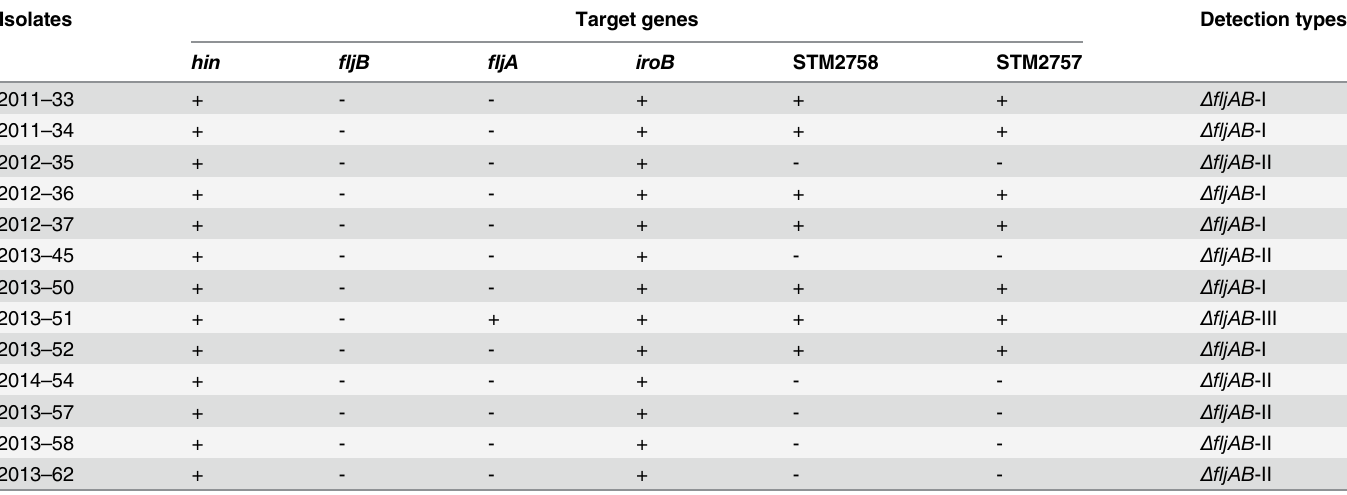
Table 5. Gene deletion profiles and types for the 13 Salmonella 1,4,[5],12:i:- isolates.